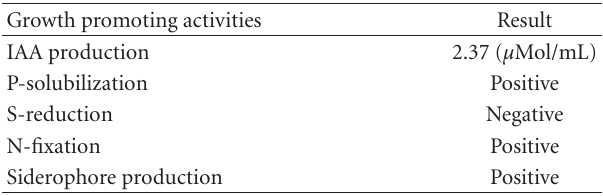
Table 4: Plant growth-promoting activities of Sporosarcina